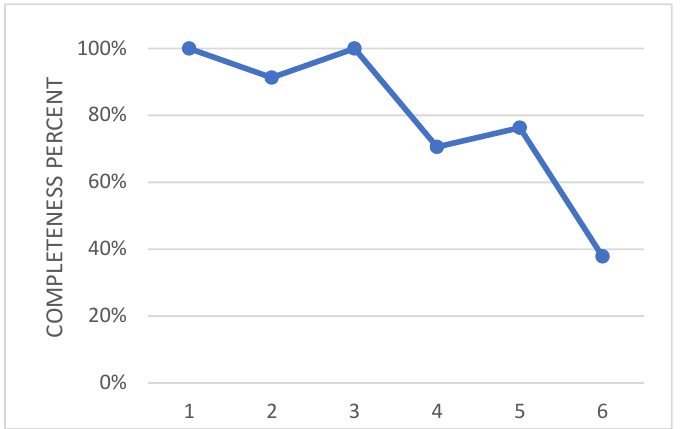
Figure 15. Overall level of maturity of the adaptive winglet actuation system.